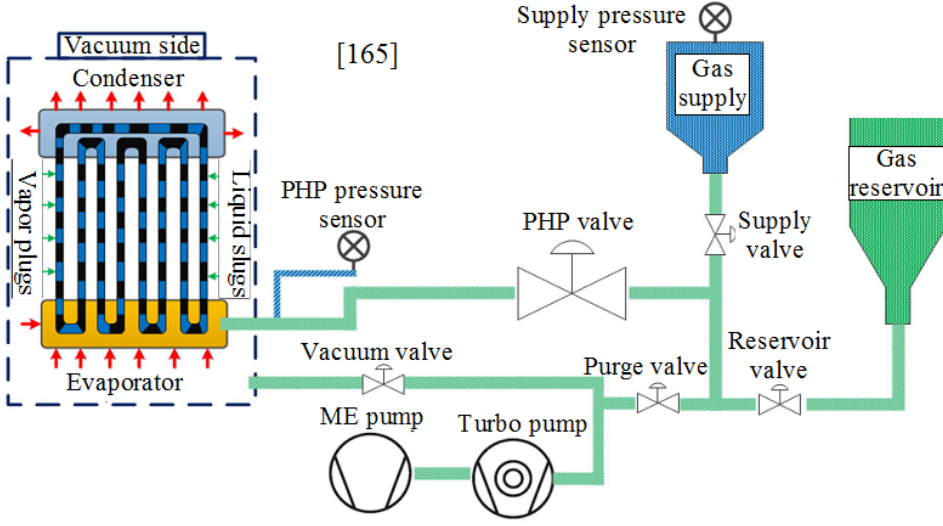
Figure 18. Low temperature PHP [165]. Fonseca et al. (2018).